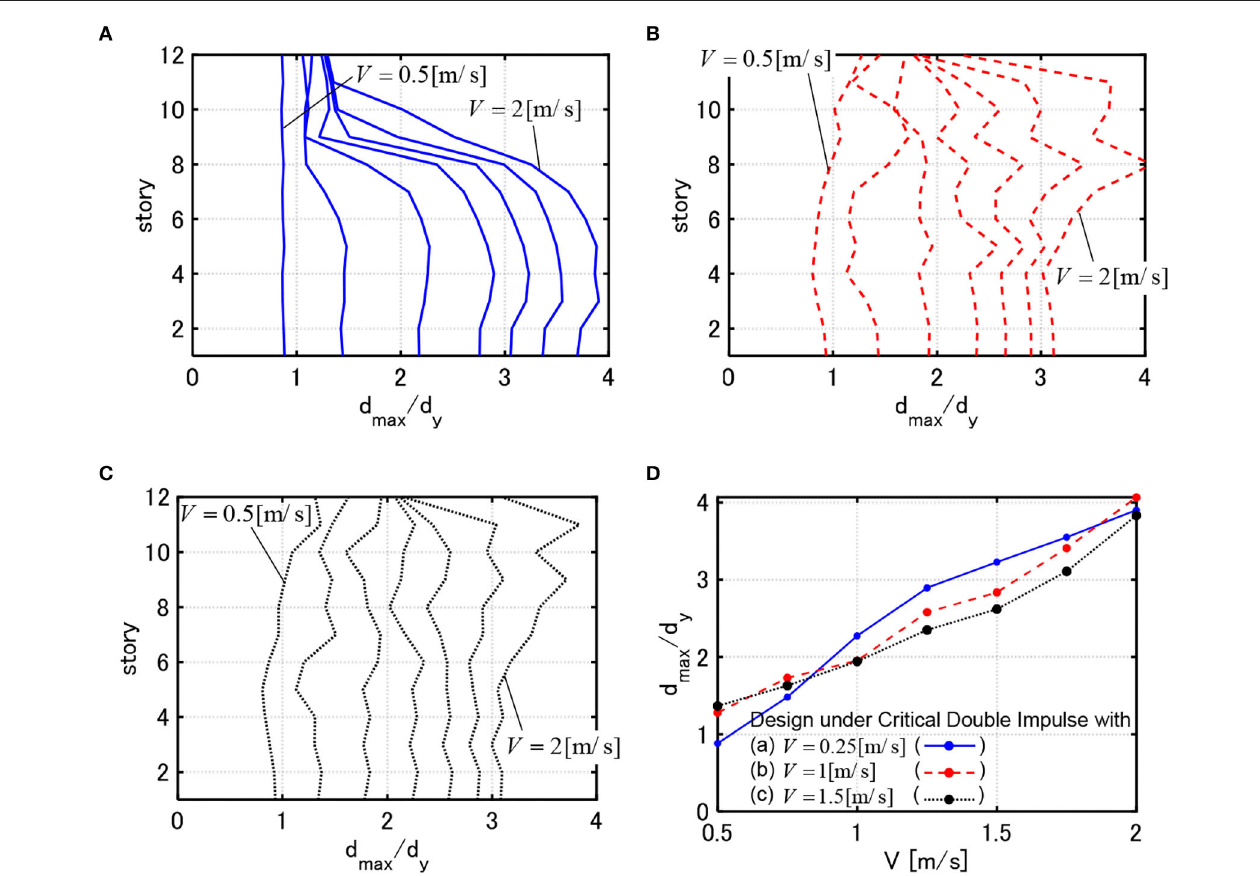
FIGURE 11 | DIP analysis for 3 models with W = 5 × 10 7 [ Ns / m ]. (A) Response of model designed under critical double impulse with V = 0.25[ m / s ]. (B) Response of model designed under critical double impulse with V = 1.0[ m / s ]. (C) Response of model designed under critical double impulse with V = 1.5[ m / s ]. (D) Comparison of maximum deformations for 3